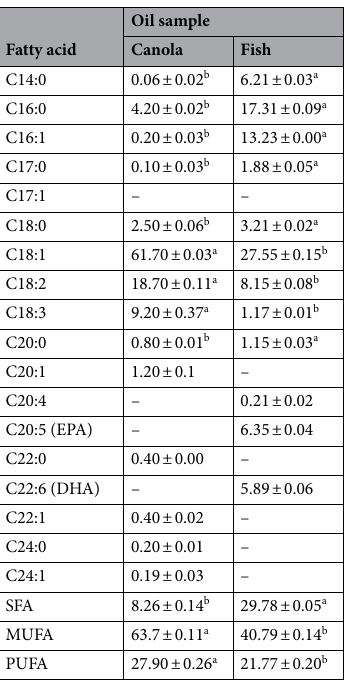
Table 1. Fatty acid composition (%w/w) of the oils studied. Means ± SD (standard deviation) within a row with the same lowercase letters are not significantly different at p < 0.05. EPA Eicosapentaenoic acid,